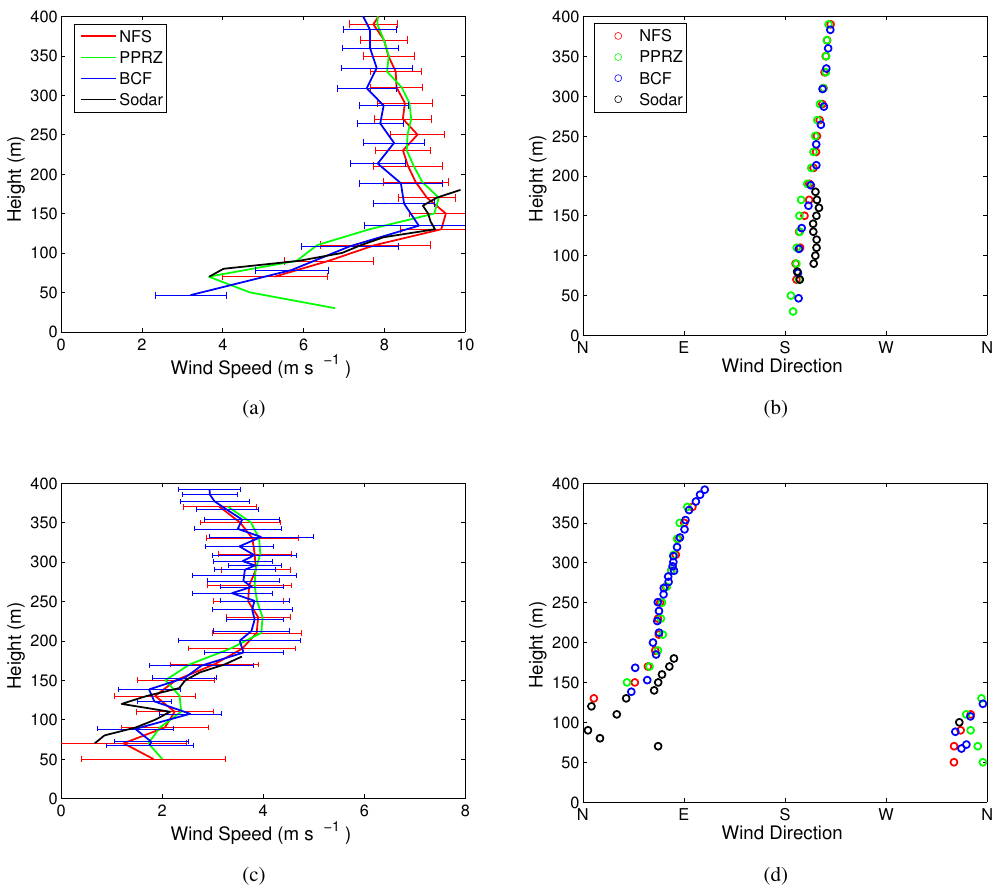
Fig. 6. Comparisons of wind profiles from a Scintec sodar (black) with derived wind speeds and directions from SMARTSonde flights. Algorithm acronyms in the legend are same as in Fig. 5. Data from (a) and (b) were taken on 31 October 2011 at 10:15LT, while data from (c) and (d) were taken on 17 November 2011 at 8:36 LT.